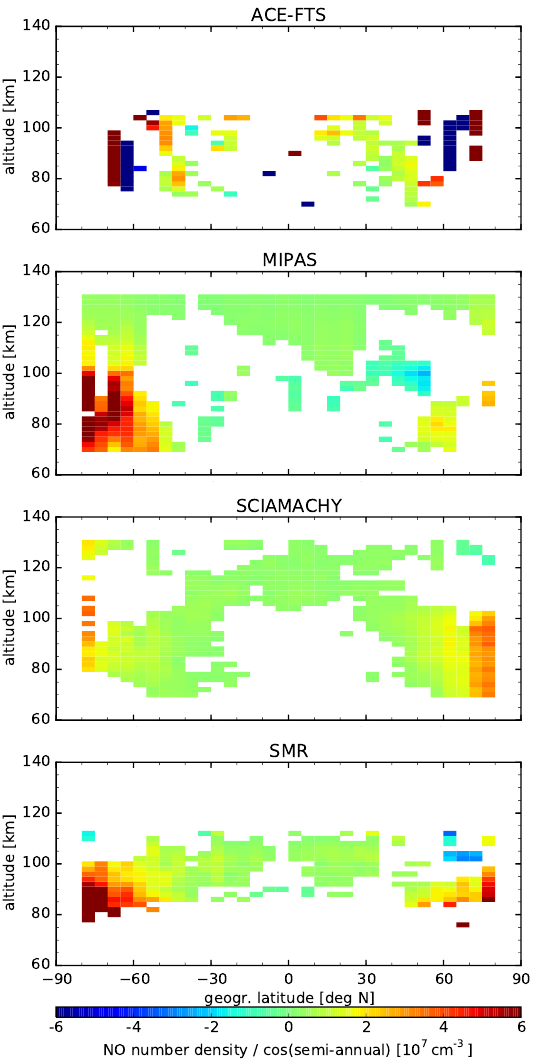
Figure 17. NO regression coefficient d 2 of the semi-annual cycle (cosine part) as in Fig 16.